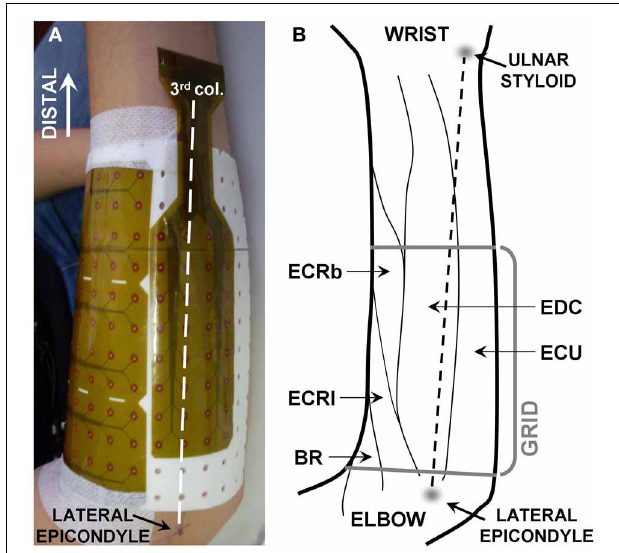
FIGURE 1 | (A) Position of the detection system. The third column of electrodes (being the first on the ulnar side) was aligned with the line linking the lateral epicondyle with the ulnar styloid. The grid consisted of 128 electrodes organized in 12 columns by 12 rows, with two groups of 4 × 2 electrodes missing in the ulnar lateral corners. The subject’s hand was kept in pronation. (B) Anatomy of the muscles of the proximal, dorsal forearm (drawing based on anatomical indications from Leijnse et al., 2008b). BR, brachioradialis; ECRl, extensor carpi radialis longus;